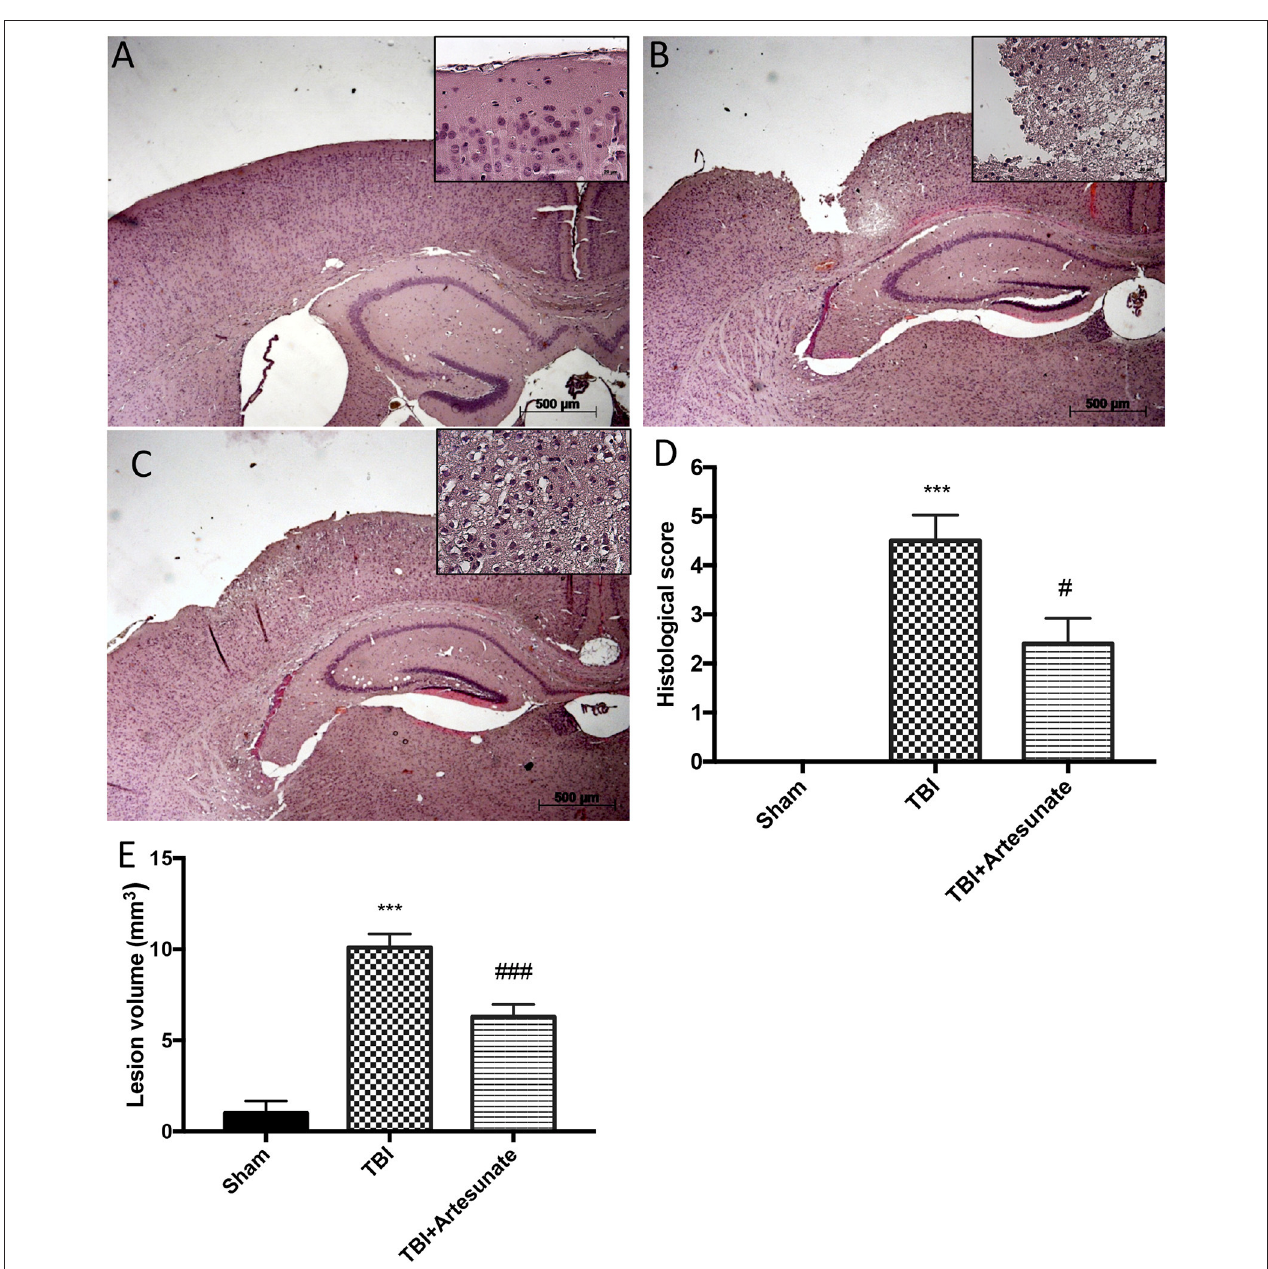
FIGURE 1 | Protective effect of artesunate treatment on histological analysis after TBI. (A) Show brain section from mice of sham group. Brain section at the level of the perilesional area showed that 24h after TBI injury the TBI group showed an evident tissue disorganization and inflammation in the perilesional area (B) . The group that has been treated with artesunate (C) at dose of 30 mg \ Kg showed a significant reduction in degree of brain injury compared with the TBI group (D) . Moreover treatment with artesunate significant reduce the lesion volume compared to TBI group as show in (E) . Data are expressed as Mean ± SEM from N = 10 Mice for each group, *** P < 0.001 vs. corresponding sham group. # P < 0.05 vs. corresponding TBI. ### P < 0.001 vs. corresponding TBI. ( F -value for histological score = 279.4. df = 2. r 2 = 0.9539) ( F -value for lesion volume = 433.9. df = 2. r 2 = 0.9698).